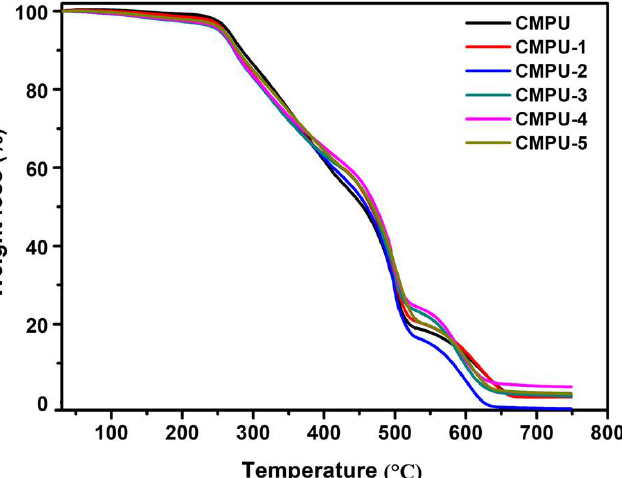
Figure 12. Thermogravimetric curves of CMPU, CMPU-1, CMPU-2, CMPU-3, CMPU-4, and CMPU-5 coated sample.